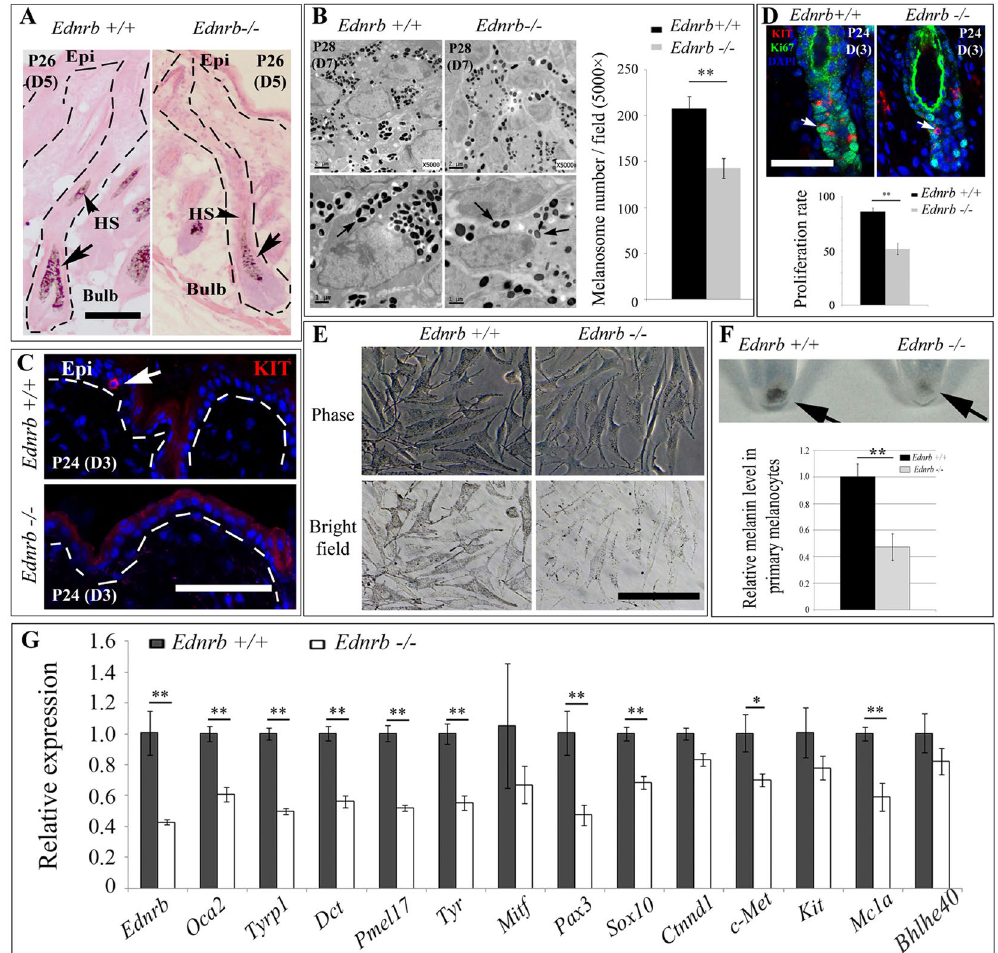
Figure 5. Loss of EDNRB blocks McSC migration into epidermis, reduces melanocyte proliferation in hair bulb and decreases expression of some melanogenesis-related genes. ( A ) Histology of scalp hair follicles from wildtype and Ednrb − / − mice 5 days post-epilation. Arrows indicate melanin granules in the hair bulb and pigmented hair bulb. ( B ) Melanosomes of wildtype and Ednrb − / − mice in the hair bulbs 7 days post-epilation revealed by transmission electron microscopy (TEM). Arrows indicate the melanosome. ( C ) Anti-KIT immunostaining of scalp from wildtype and Ednrb − / − mice 3 days after epilation. Note lack of KIT- positive cells in Ednrb − / − epidermis 3 days after epilation. ( D ) Anti-KIT and Ki67 immunostaining of hair follicles from wildtype and Ednrb − / − mice 3 days post-epilation (upper panels) and the quantitative graph of melanocyte proliferation in the hair bulb (lower panel). ( E ) Images of primary cultures of melanocytes from wildtype and Ednrb − / − mice and ( F ) corresponding cell pellets (upper panel) and melanin content (lower panel). Arrows point to the cell pellet. ( G ) qRT-PCR analysis for expression of melanogenesis-related genes in scalp skin of wildtype and Ednrb − / − mice 7 days after epilation. Epi, epidermis; HS, hair shaft. Bar, 50 μ m. * Indicates p < 0.05; ** indicates p <